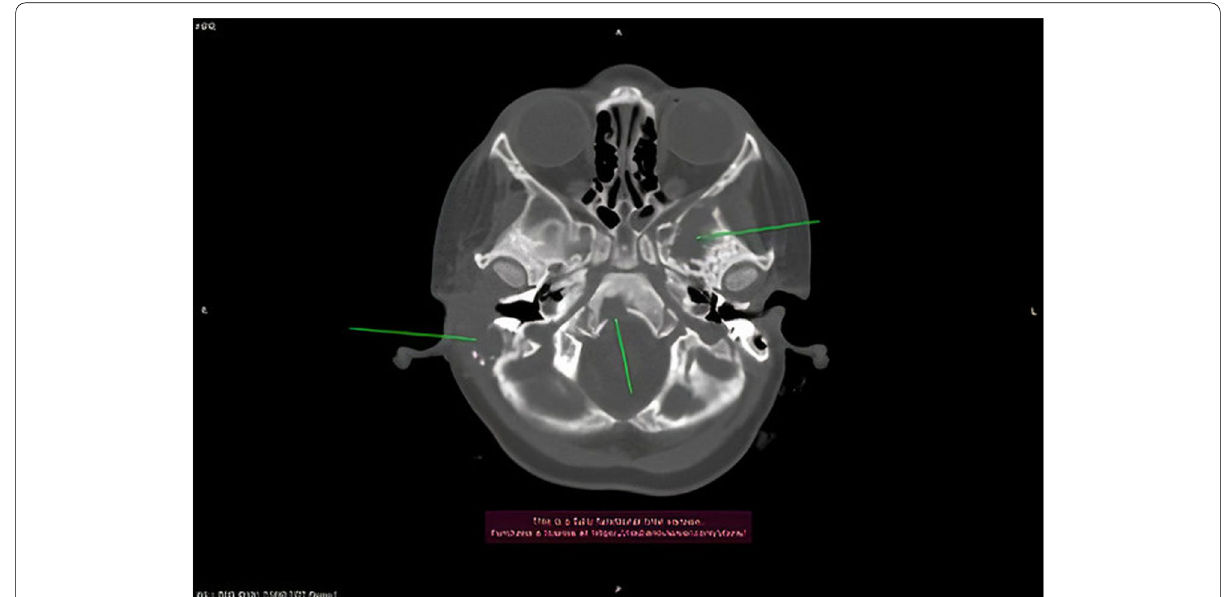
Fig. 1 Axial thin-section non-contrast bone window CT images show bone lesions in extension in the right temporal bone, left wing of the sphenoid bone, and clivus